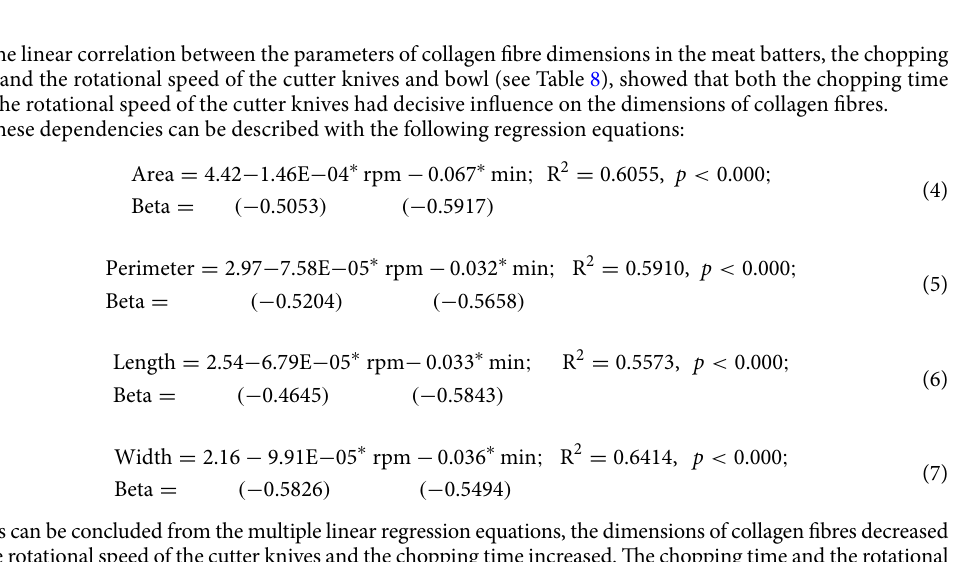
Table 8. The linear correlation between the parameters of the collagen fibre dimensions and the rotational speed of the cutter knives and bowl. *significance levels of correlation coefficients ( p ≤